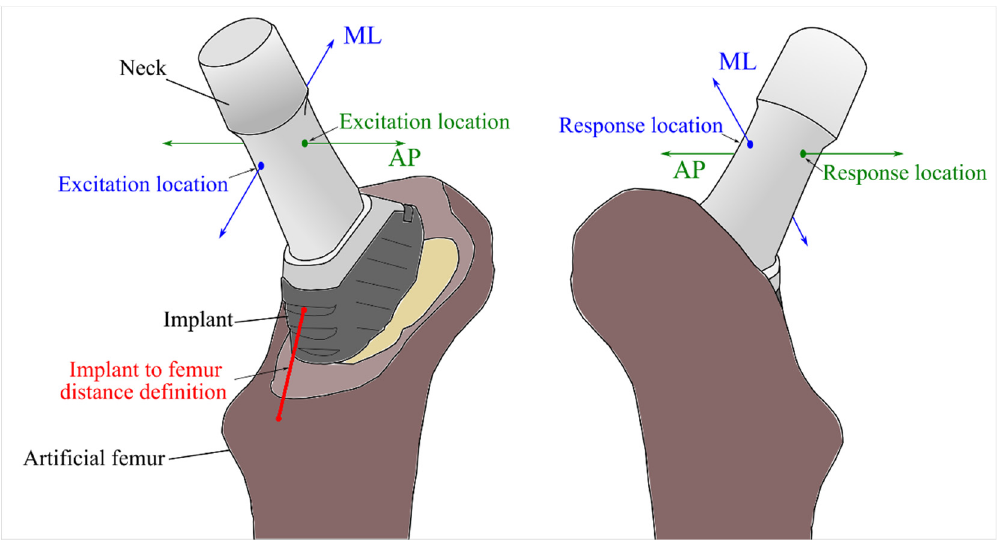
Figure 1. Excitation and response locations on the implant